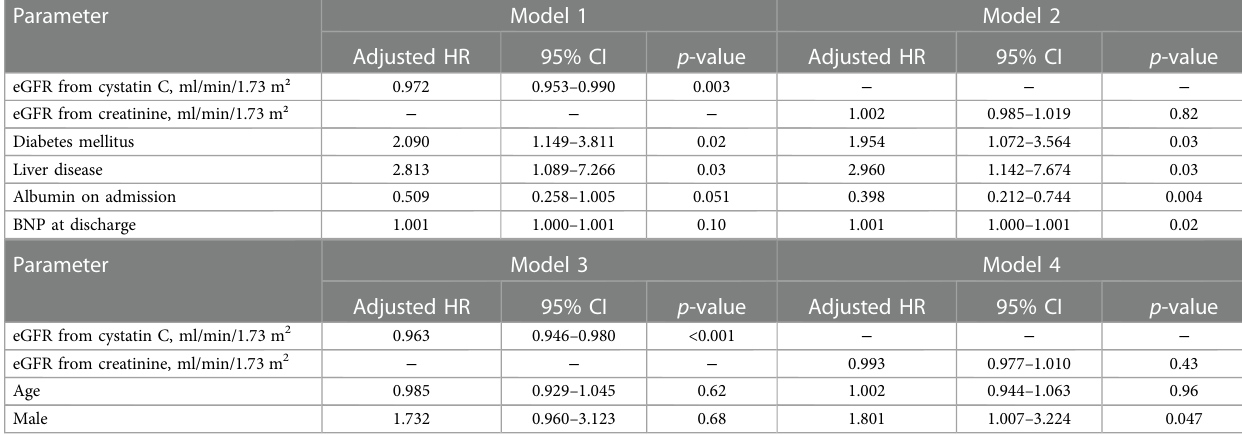
TABLE 4 Cox regression multivariate analysis for the association between cumulative mortality and clinical fi ndings; model 1, 2, 3 and